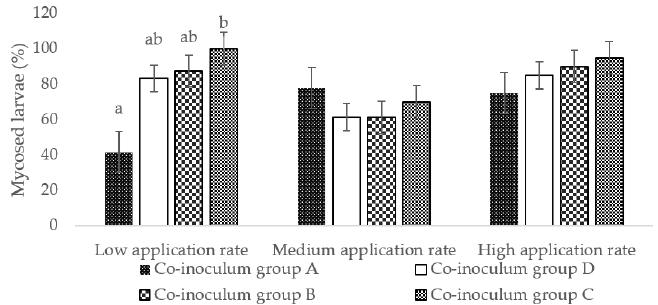
Figure 7. Percentage of cadavers supporting sporulation after the four combined treatments at the three application rates (error bars represent ANOVA; multiple comparisons using Tukey’s HSD three application rates (error bars following letters represent ANOVA; multiple comparisons using test). Tukey’s HSD